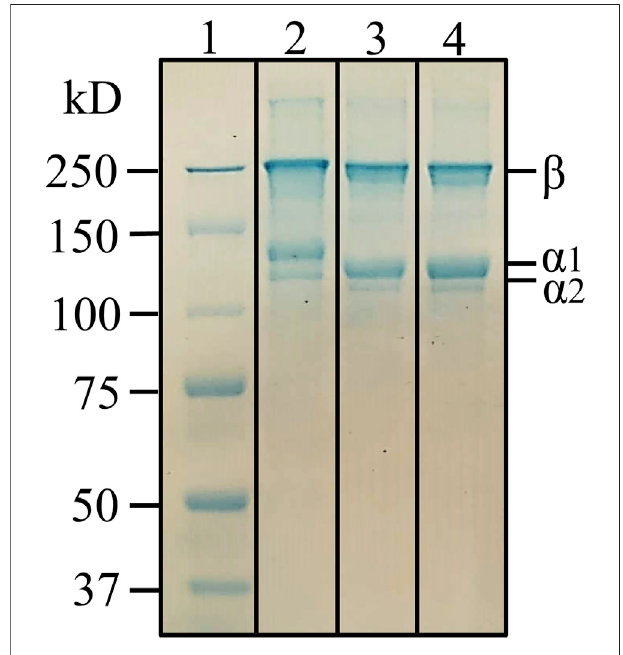
FIGURE 2 | Electrophoretic pro fi le of (1) molecular weight standards; (2) commercial collagen type I from calf skin; (3) protein rich extract using conventional solvent; (4) protein rich extract from NADES